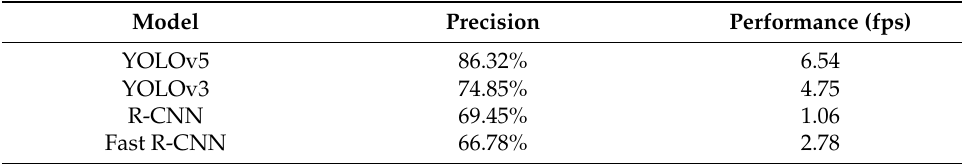
Table 1. Comparative analysis of apple detection algorithms. Model